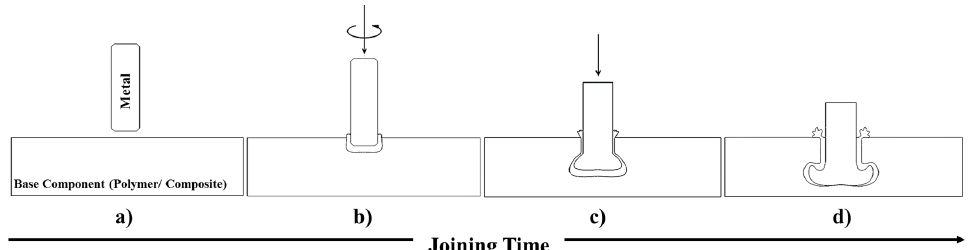
Figure 1. Steps of the FricRiveting process in metallic-insert joints. ( a ) Positioning of the joining parts; ( b ) insertion of the rotating metallic rivet into the polymeric plates (frictional phase); ( c ) plastic deformation of the rivet tip by increasing the axial force (forging phase); ( d ) joint consolidation.